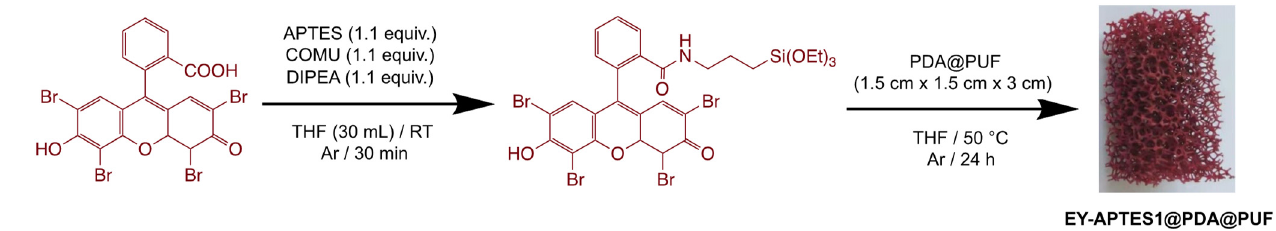
Figure 9. One-pot COMU-mediated eosin-Y-APTES coupling and APTES-PDA condensation for choring EY-APTES on PDA@PUF. anchoring EY-APTES on